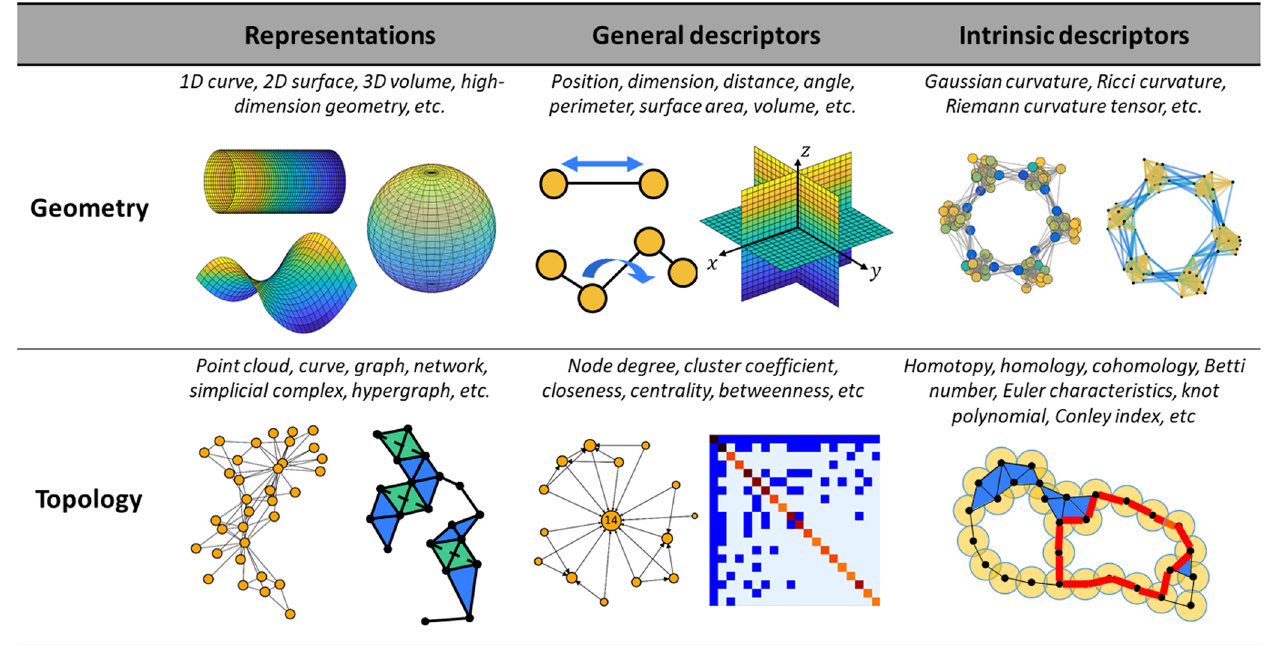
Fig. 1 Illustration of geometrical and topological representations, general descriptors and intrinsic descriptors. Compared to general descriptors, intrinsic descriptors provide highly-abstract and generalized quantities that characterize the most intrinsic and fundamental structural